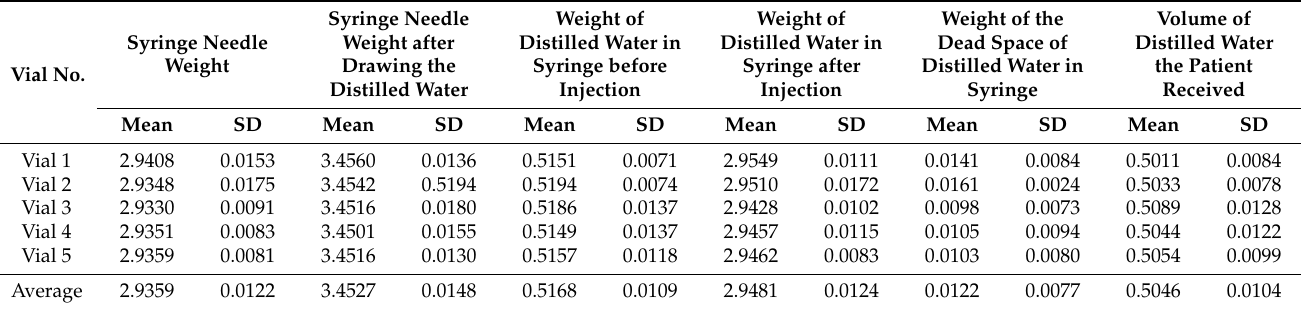
Table 1. First stage using distilled water in the hypothetical situation.